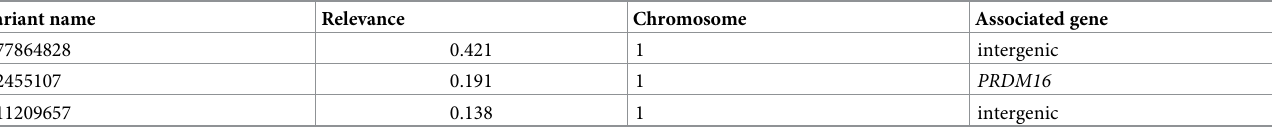
Table 3. Posterior probability of relevance with respect to migraine for SNPs with main effects.